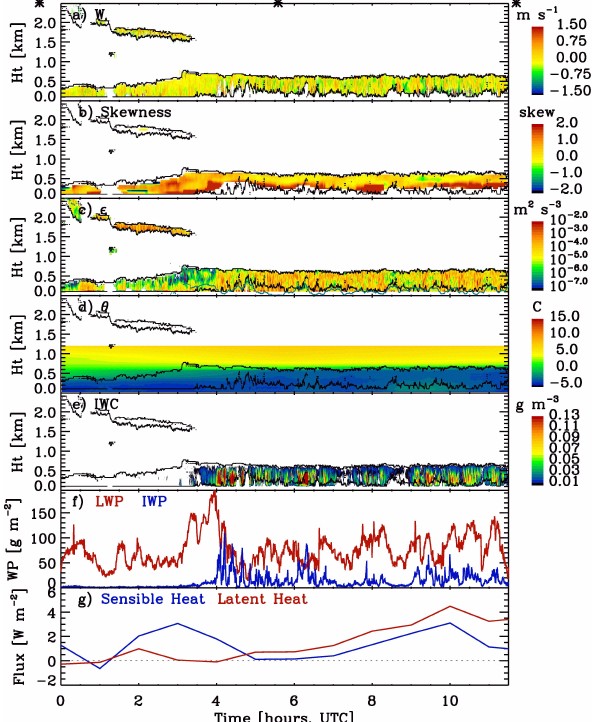
Fig. 9. Remote-sensor-derived cloud and atmosphere dynamical properties for 25 August 2008 (Case #3), including (a) vertical ve- locity within the liquid cloud layer, (b) skewness of vertical velocity over running 30min windows, (c) turbulent dissipation rate, (d) po- tential temperature, (e) IWC, (f) LWP (red) and IWP (blue), and (g) surface turbulent sensible (blue) and latent (red) heat fluxes. Liquid cloud boundaries are given in black in the upper five pan- els, while the base of the cloud-driven mixed layer is given in blue in (c) . Launch times for the radiosondes in Fig. 10 are given as stars across the top axis.